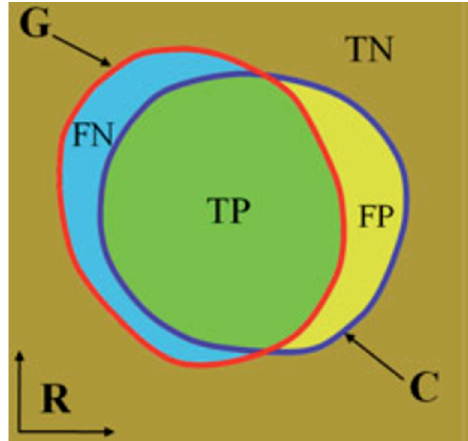
Figure 3. Illustration of segmentation accuracy and errors of the proposed automatic segmentation (C) by comparing to the ground truth (G) [5]. (C) by comparing to the ground truth (G)